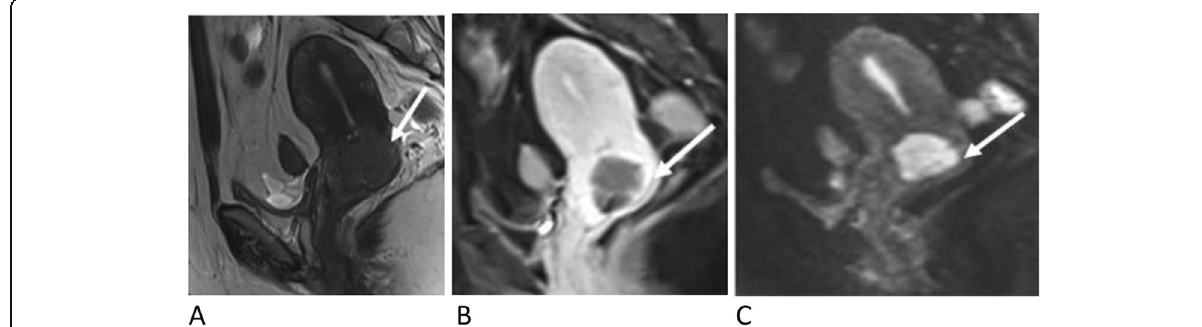
Fig. 1 A 42-year-old female patient presented with vaginal bleeding. MRI was done. a Sagittal T2WI revealed a relatively hyperintense signal focal lesion compared with the surrounding cervical stroma seen extending along the endocervix and endocervical canal. b Late post-contrast sagittal T1WI, the lesion showed non-homogenous enhancement at the late post-contrast study. c DWI, the lesion showed restricted diffusion with high b value (800) and corresponding low signal at ADC map. Diagnosis: cervical